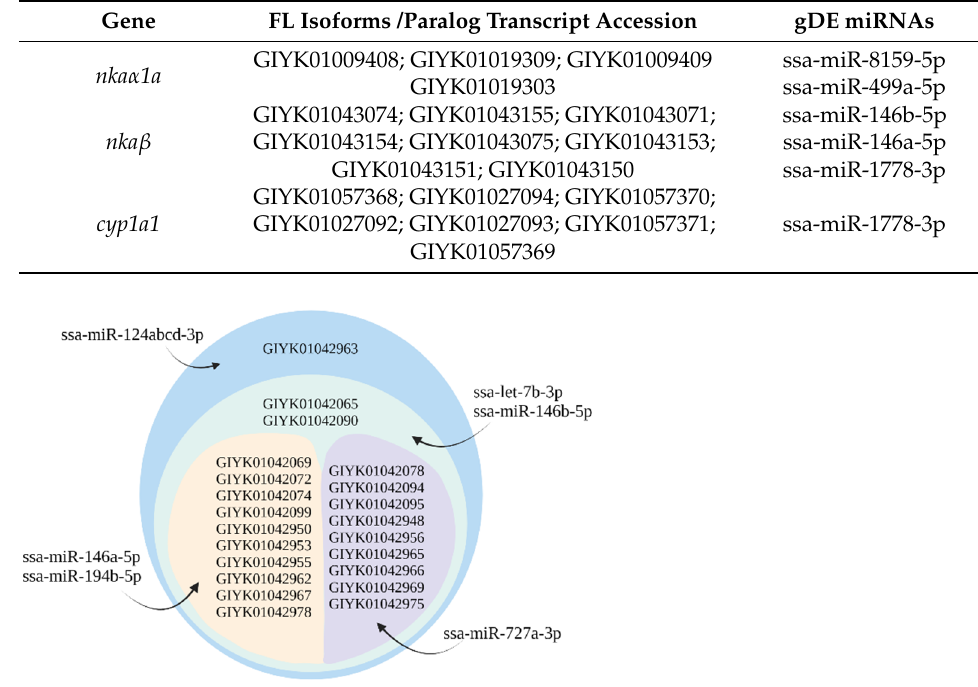
Table 3. gDE miRNAs targeting nka α 1a , nka β and cyp1a1 isoforms.